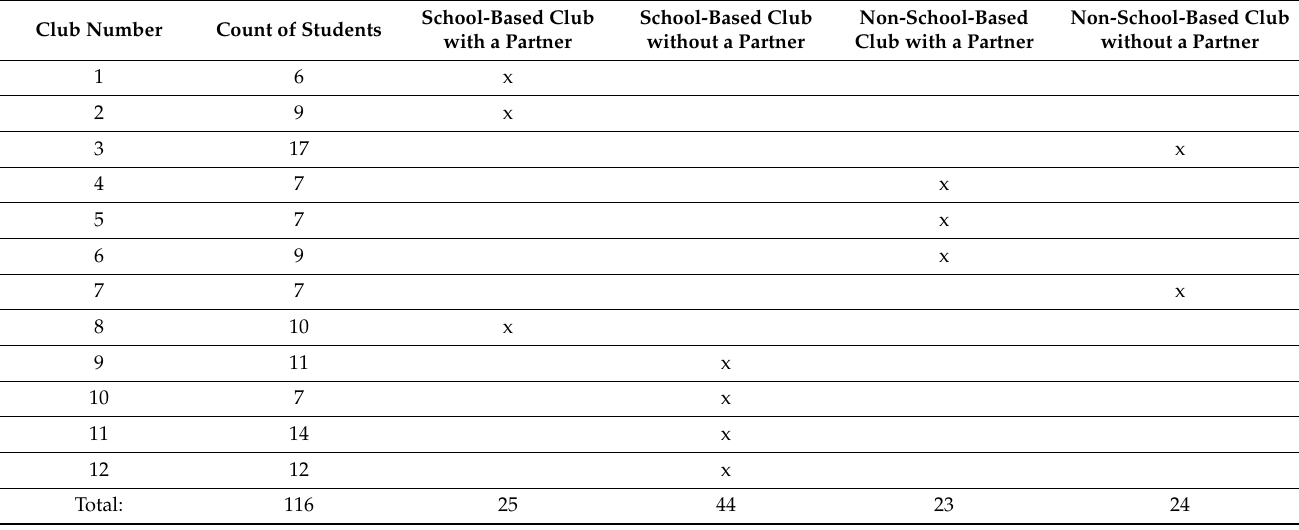
Table A1. Distribution of students across club types, with “x” indicating which type the club